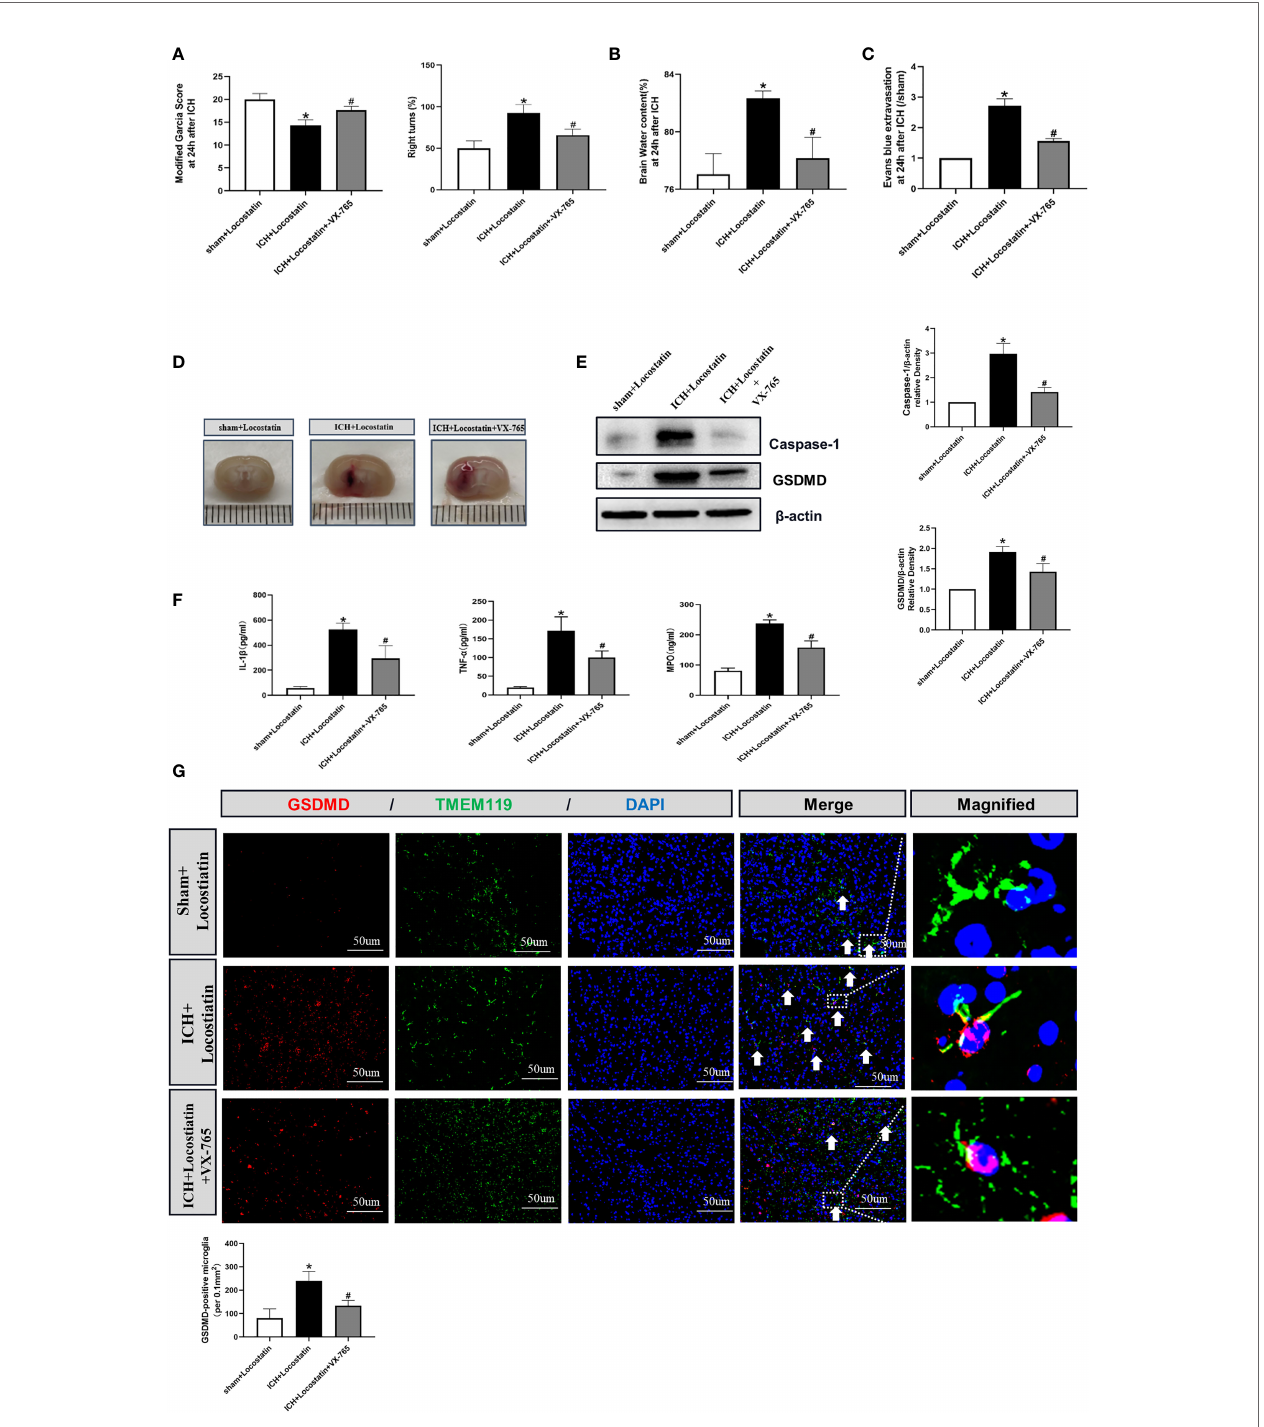
FIGURE 7 | VX-765 ameliorated microglial pyroptosis and brain injury after Locostatin-treated ICH. (A – D) Neurological de fi cits, brain water content, EB extravasation, and hematoma size were tested at 24 h after ICH. (E) Representative Western blot bands and densitometric quanti fi cation of Asc, Nlrp3, Caspase-1, and GSDMD. n = 6 for each group. * p < 0.05 vs. sham; # p < 0.05 vs. ICH+vehicle. (F) IL-1 b , TNF- a , and MPO production was tested by ELISA assay. n = 6 for each group. * p < 0.05 vs. sham; # p < 0.05 vs. ICH+vehicle. (G) GSDMD/TMEM119 double immuno fl uorescence staining and quantitative analysis of GSDMD-positive microglia. Scale bar = 50 m m. n = 3 for each group. * p < 0.05 vs. sham; # p < 0.05 vs.